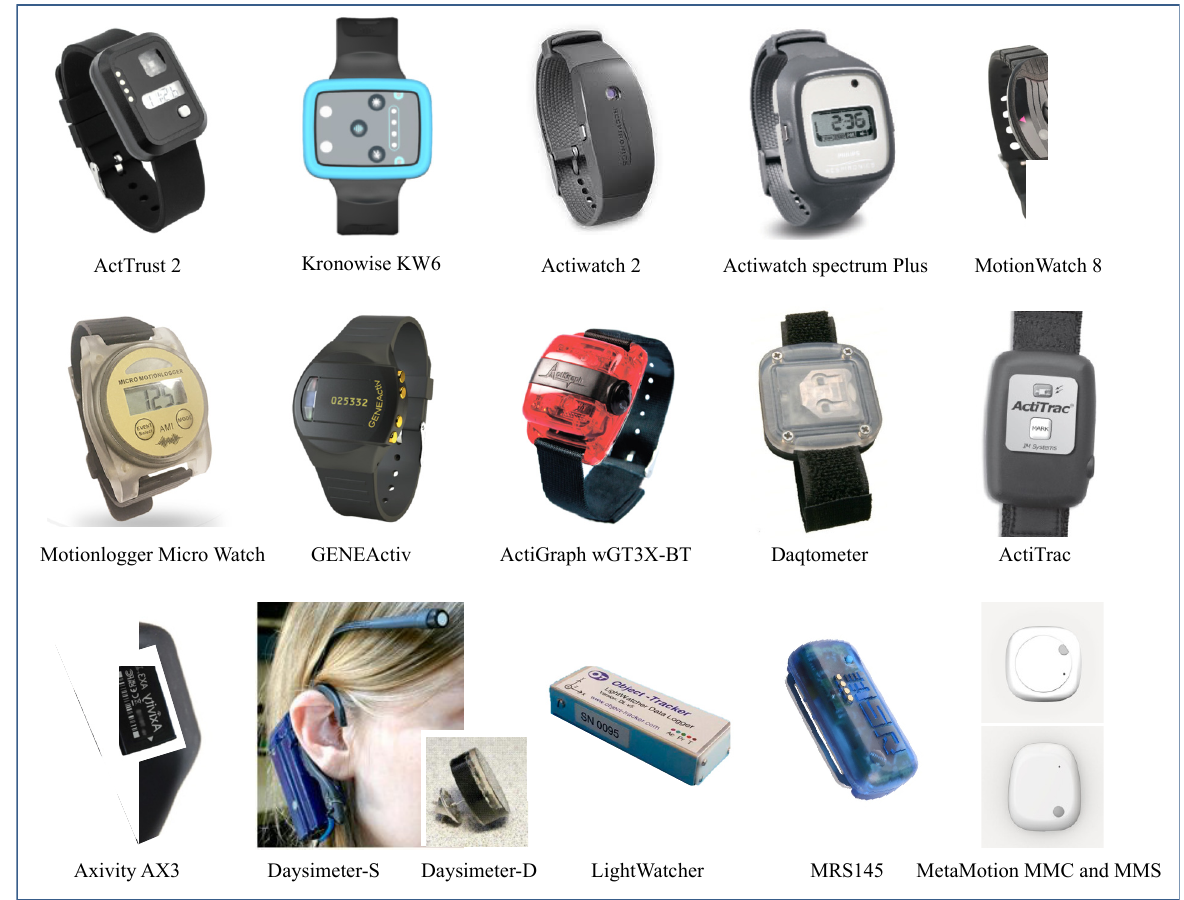
Figure 1. Reviewed dataloggers (pictures taken from manufacturers’ websites or scientific articles (mentioned in Table S1)).